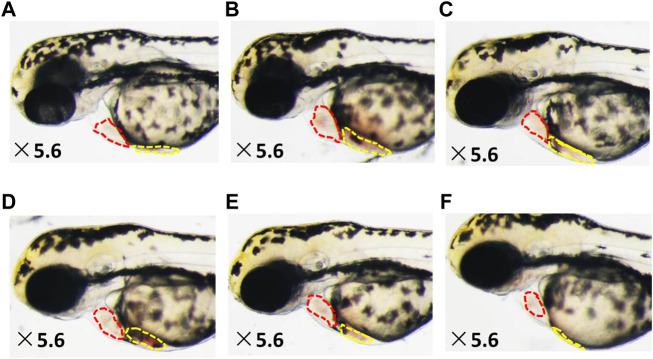
Reduced heart dilatation and venous congestion in HF zebrafish treated with SYDC for 4 h. (A) Vehicle-treated zebrafish; (B) zebrafish treated with verapamil alone; and HF zebrafish treated with digoxin, SYDC-low dose, SYDC-middle dose, and SYDC-high dose, resulting in significantly decreased heart dilatation and venous congestion (C–F). The red-dotted lines indicate the heart area of zebrafish; the yellow-dotted lines indicate the venous congestion area of zebrafish.